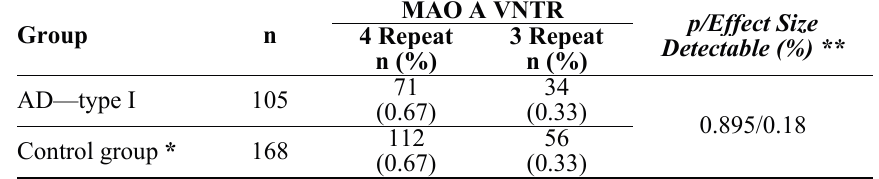
Table 2. Frequency of genotypes of the polymorphism uVNTR of the MAOA gene in patients with alcohol dependence (AD) with Lesch type I and in